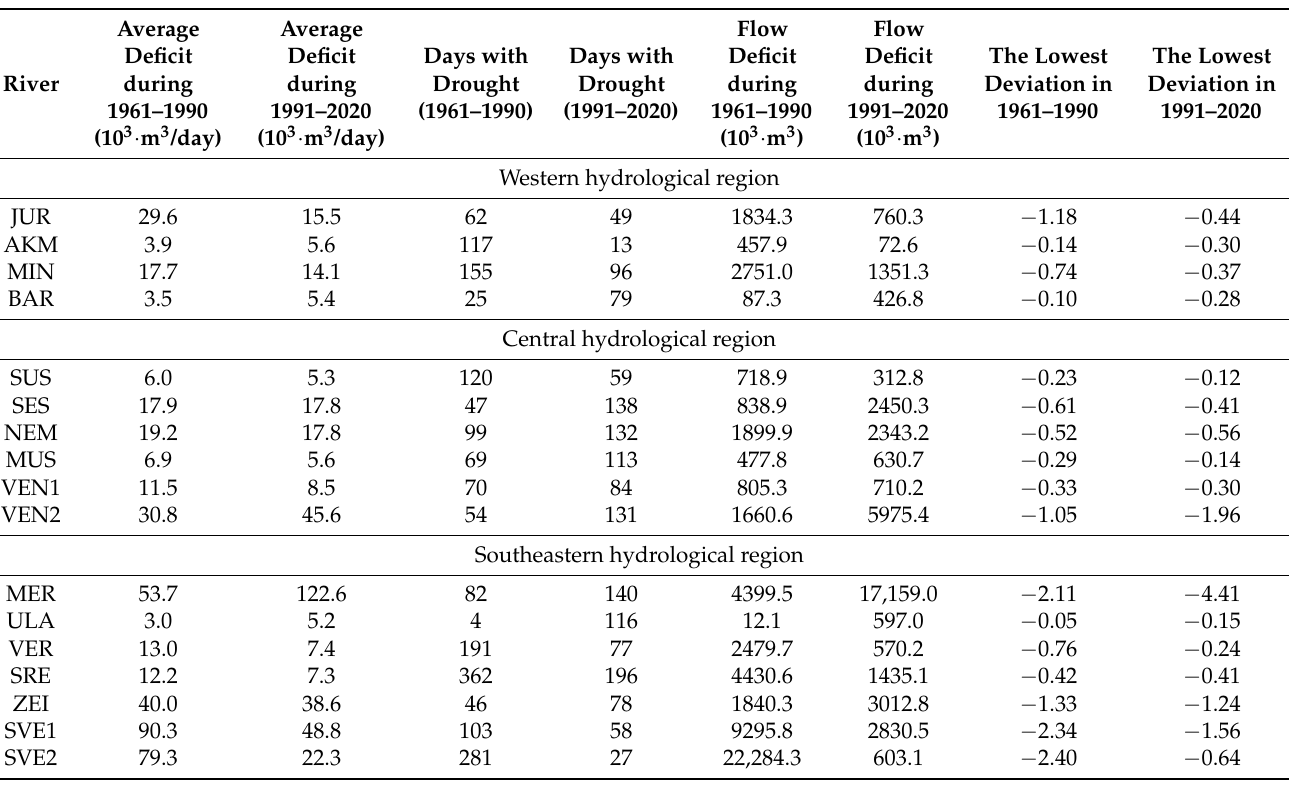
Table 4. Changes for 30Q95.